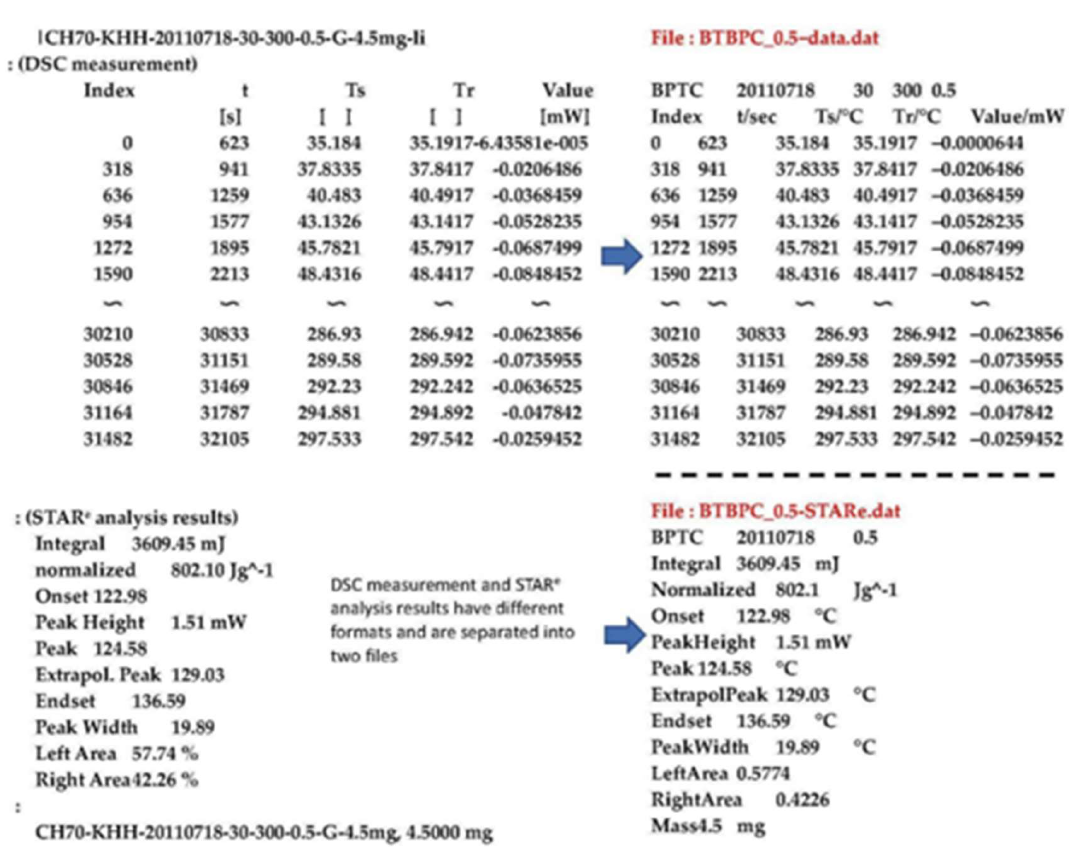
Figure 1. DSC data structure and data cleansing for